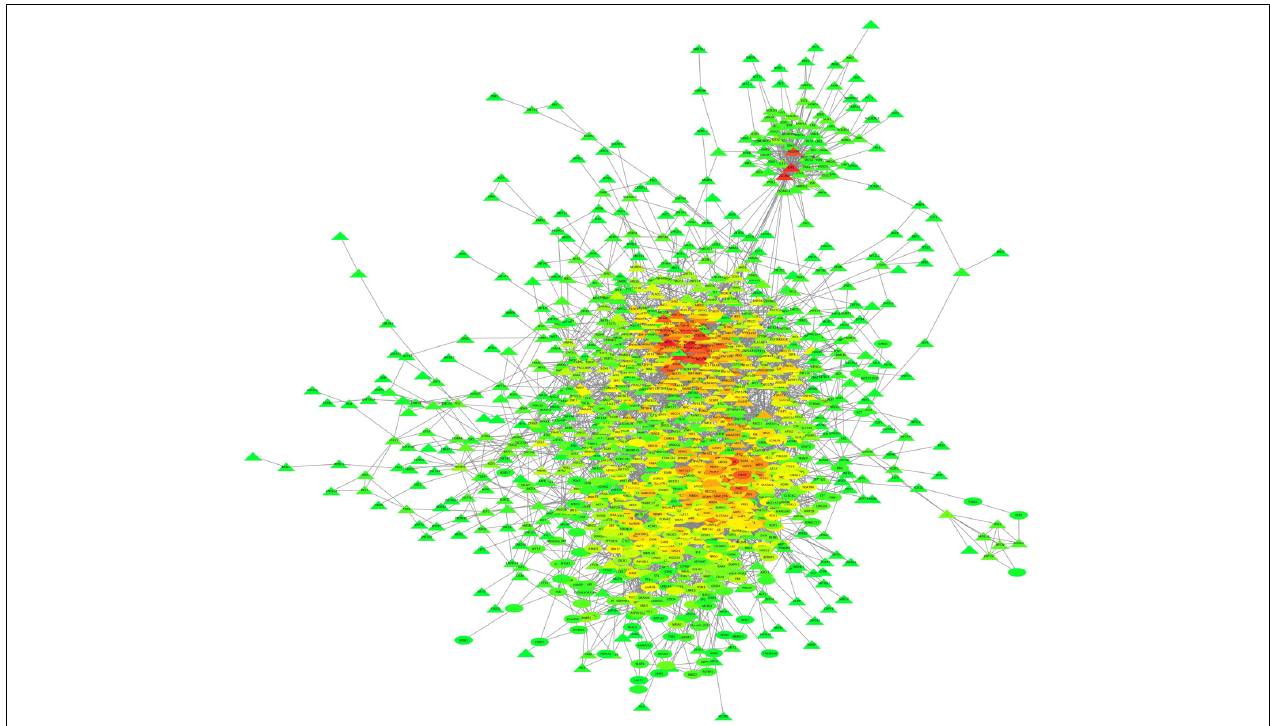
FIGURE 2 | Liver gene co-expression network constructed by PCIT in pre- and post-puberty Brahman heifers. The entire network comprises 1,408 nodes (or genes) and 8,330 interactions. The color spectrum ranges from green to red for low and high number of connection,